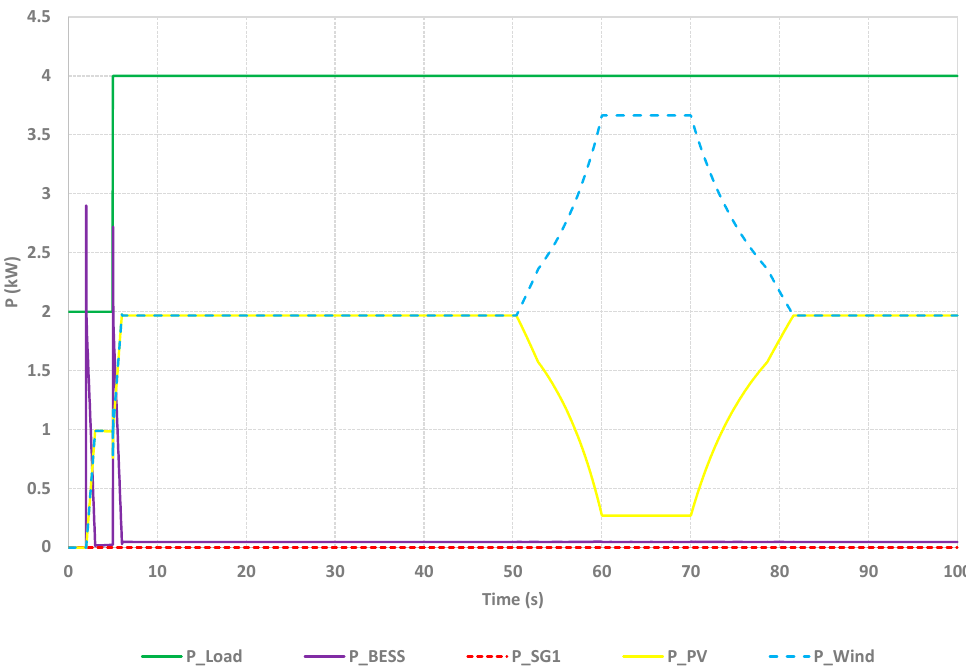
Figure 13. Scenario 3a: Cloud transient analysis for maximum solar PV and wind generation for a 4 kW demand with the BESS.